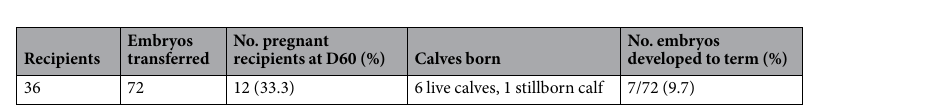
Table 2. Pregnancy and calf birth following transfer of transgenic SCNT embryos to recipient